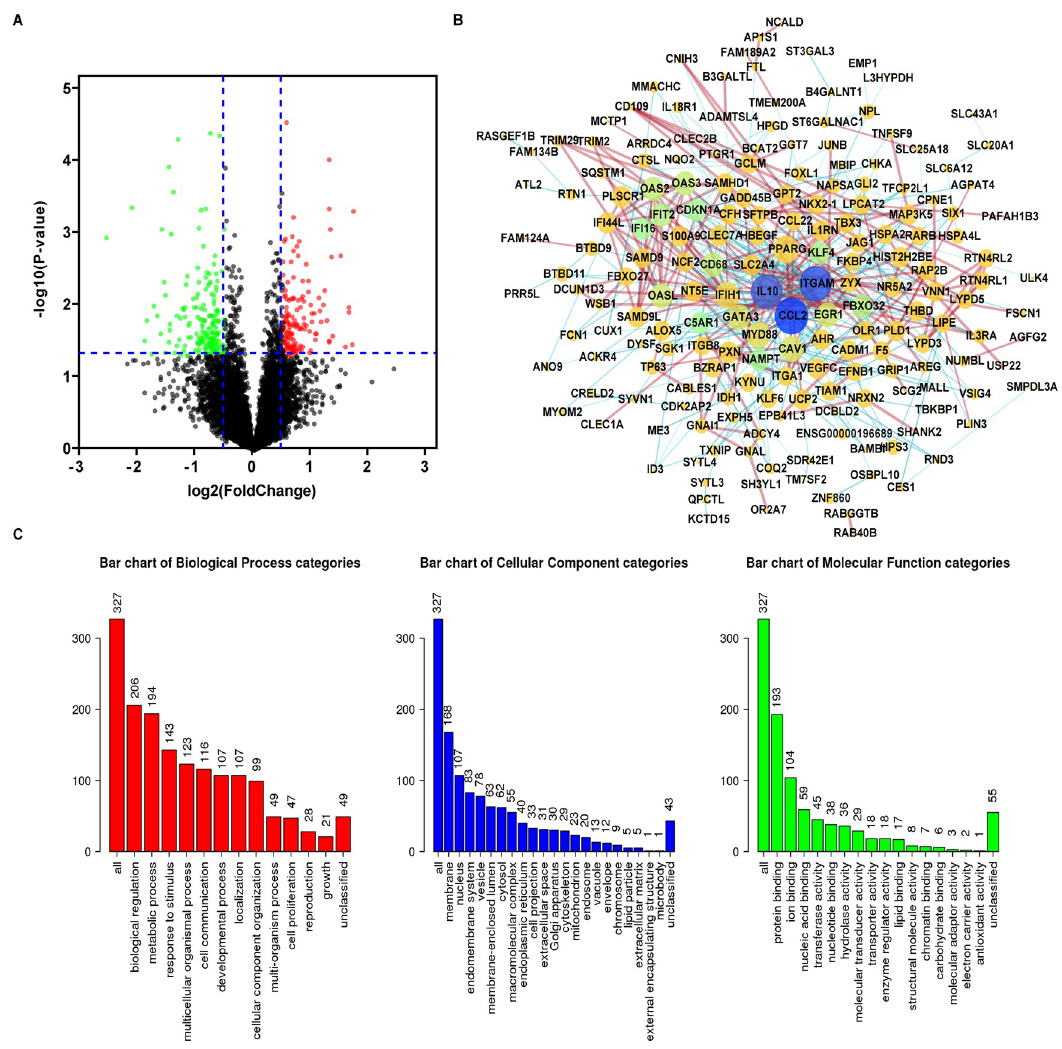
Fig 7. Functional enrichment analysis of ADARB1-associated co-DEGs in LUAD samples. (A) The coexpression genes of ADARB1 are shown as a volcano plot. (B) The PPI network of ADARB1-associated co-DEGs as completed by the STRING and Cytoscape software. (C) GO analysis of ADARB1 associated